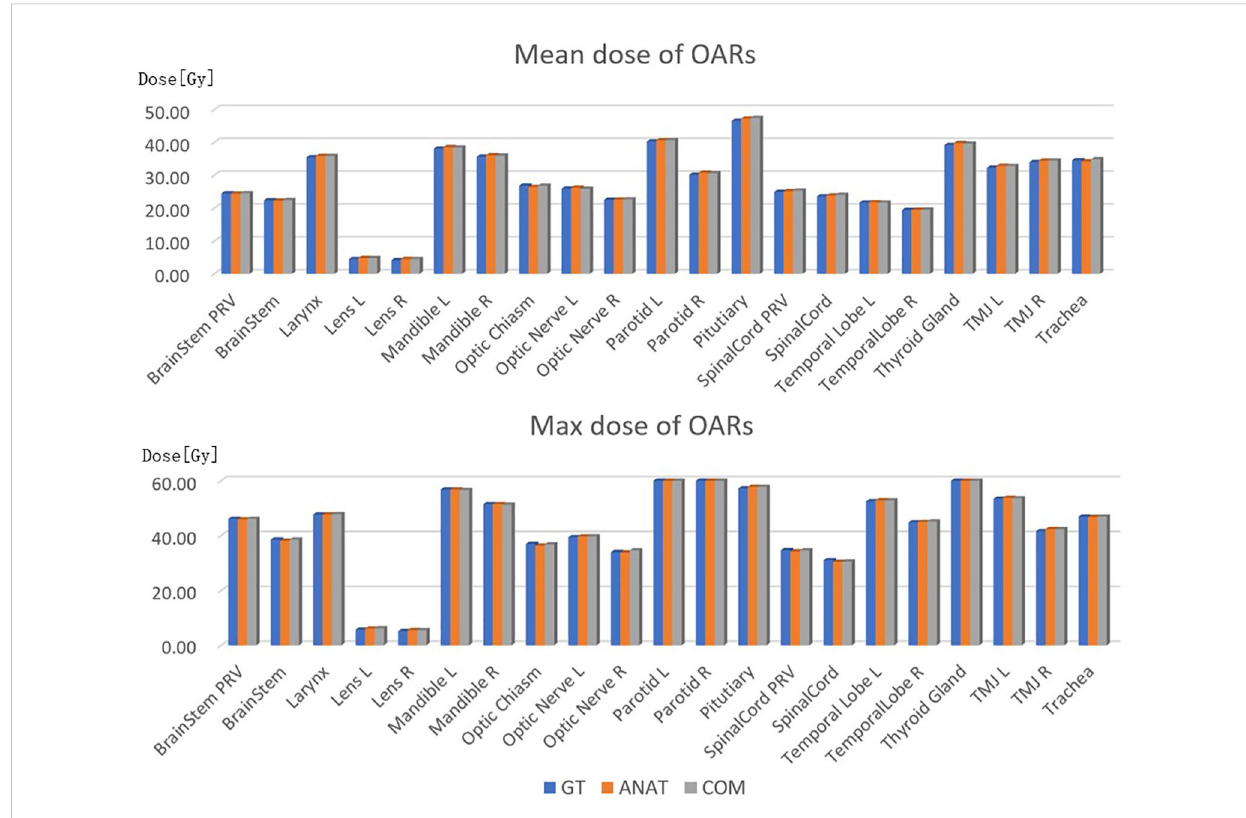
FIGURE 5 Comparison of the dosimetric parameters between the two models.